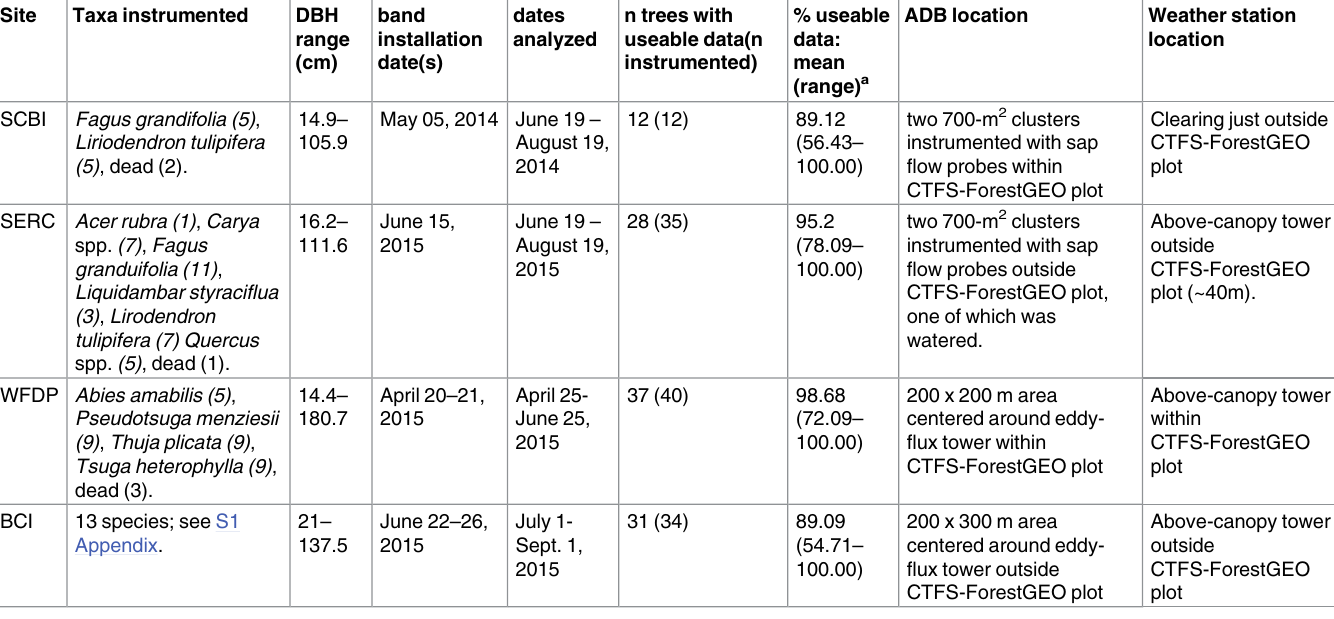
Table 2. Measurement details by